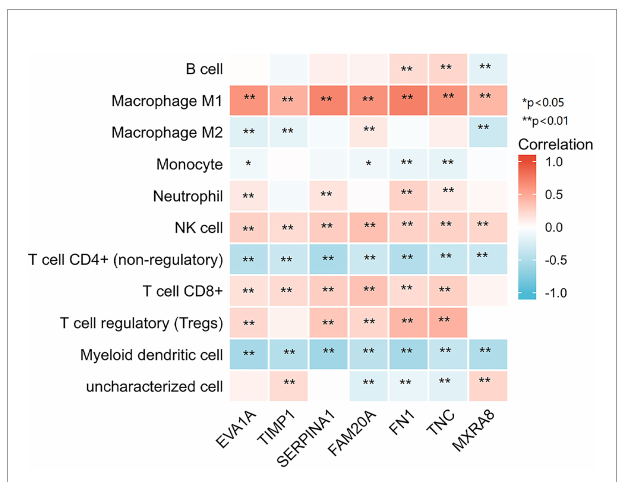
FIGURE 5 | 7 genes respectively in relation to the level of immune cell in fi ltration. *p < 0.05, **p < 0.01.